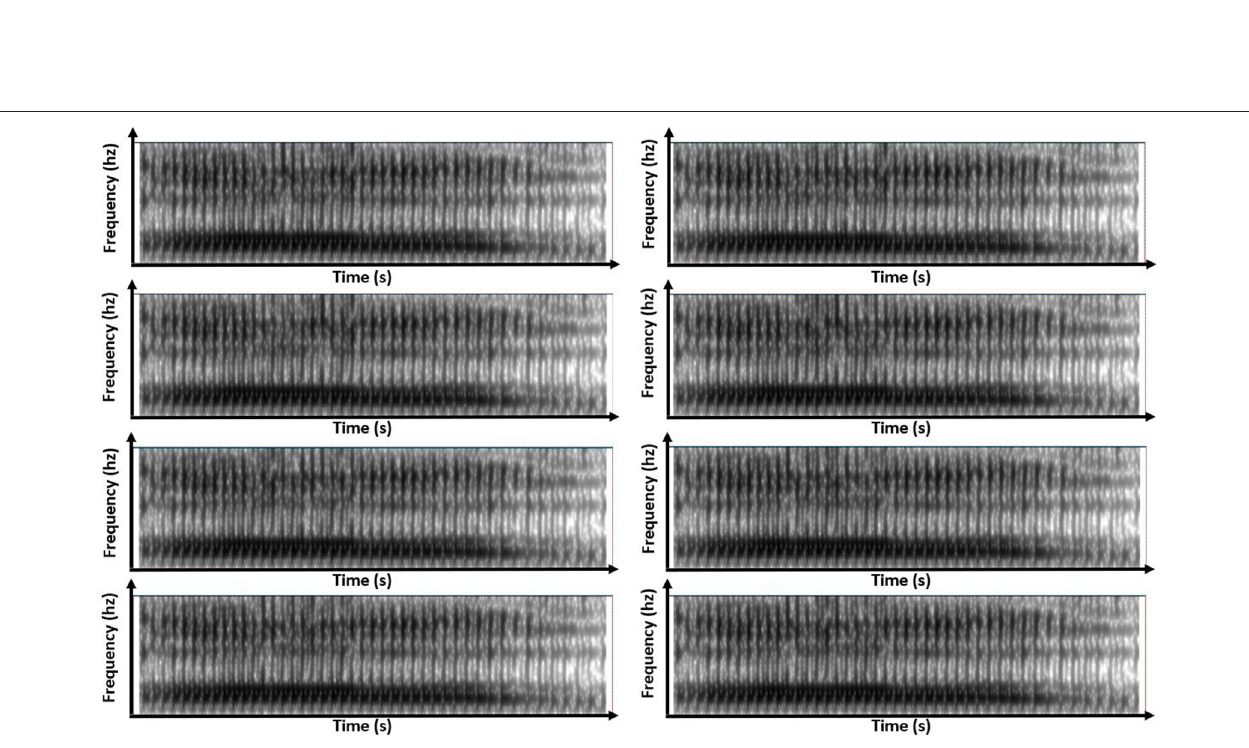
Frontiers in Physiology |